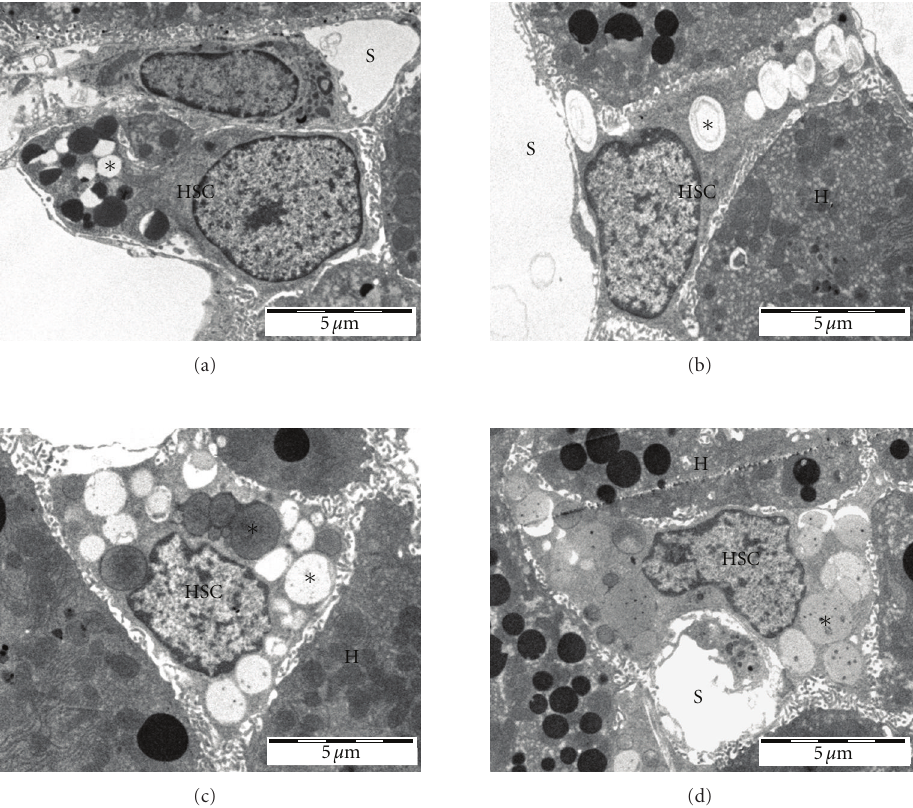
Figure 1: Representative transmission electron micrographs of HSC (HSC) from young (a,b) and old rats (c,d). Hepatic stellate cell, HSC; sinusoidal lumen, S; hepatocyte, H; lipid droplets ∗ .